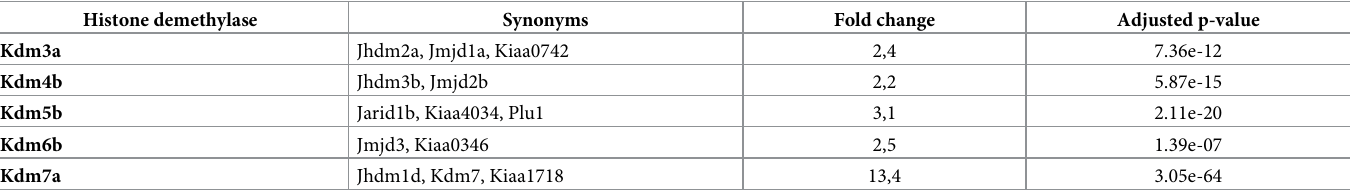
Table 1. More than two-fold differentially expressed histone demethylases in MC3T3-E1 cells differentiated for 21 days compared to undifferentiated subconfluent cells in RNA-seq analysis. Histone